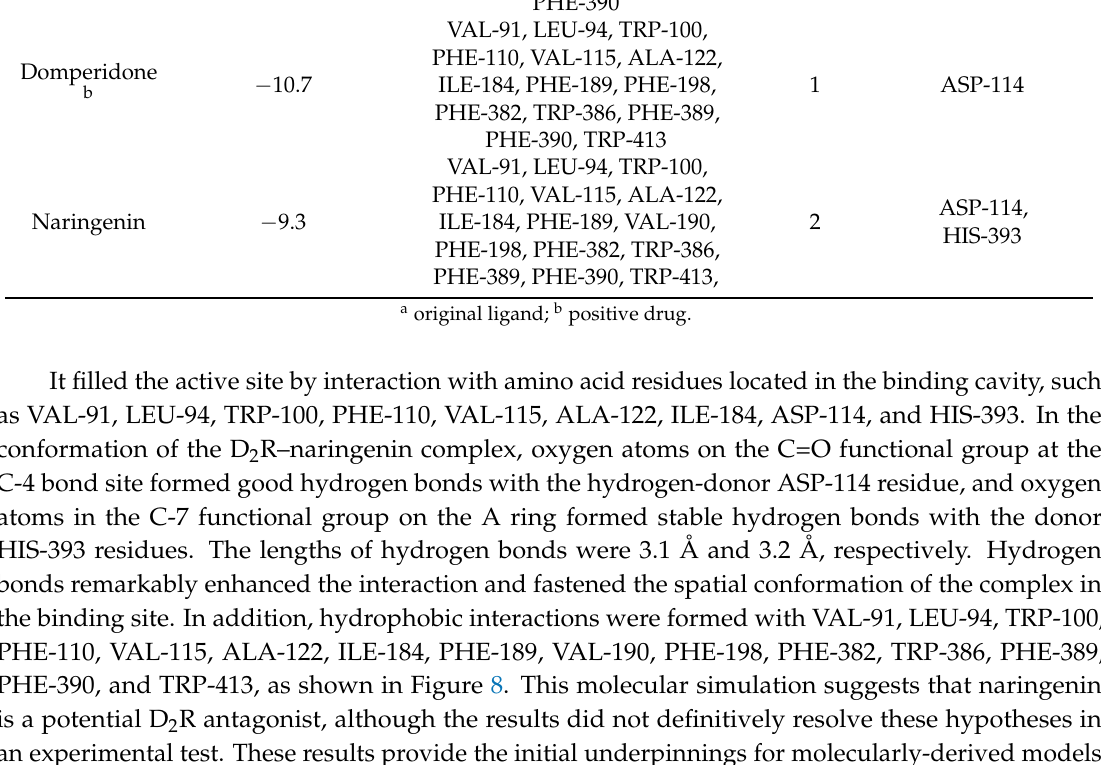
Hydrophobic Residues (within a range of 4 Å) TRP-100, PHE-110, VAL-115, ALA-122, PHE-198, PHE-382, TRP-386, PHE-389,